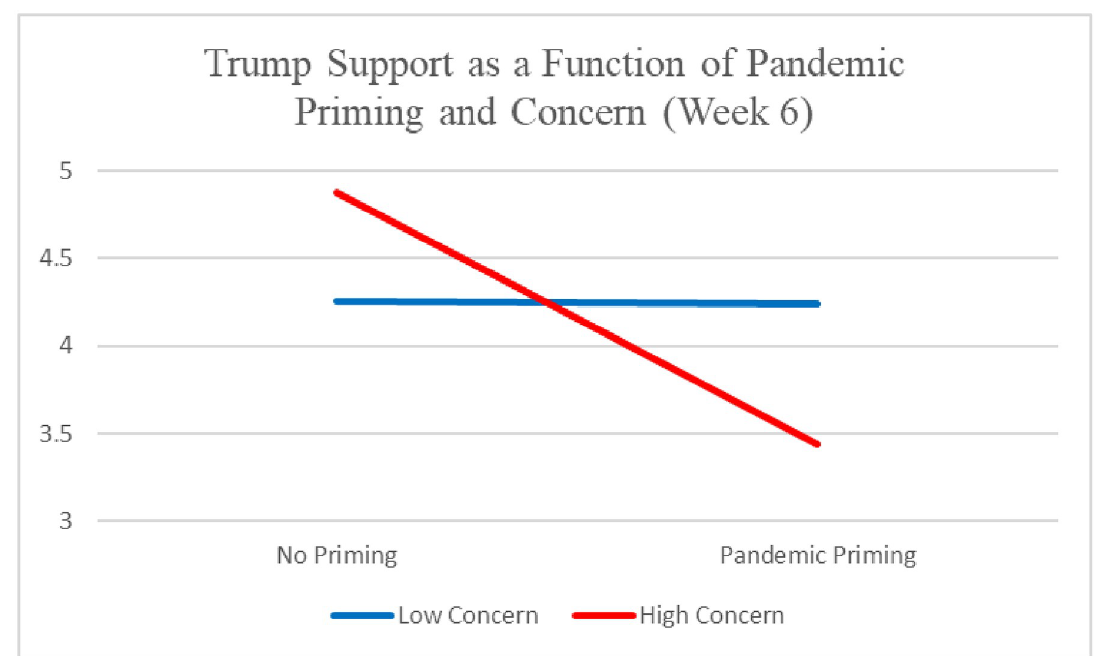
Fig 2. Republican Trump support as a function of pandemic priming and concern (week